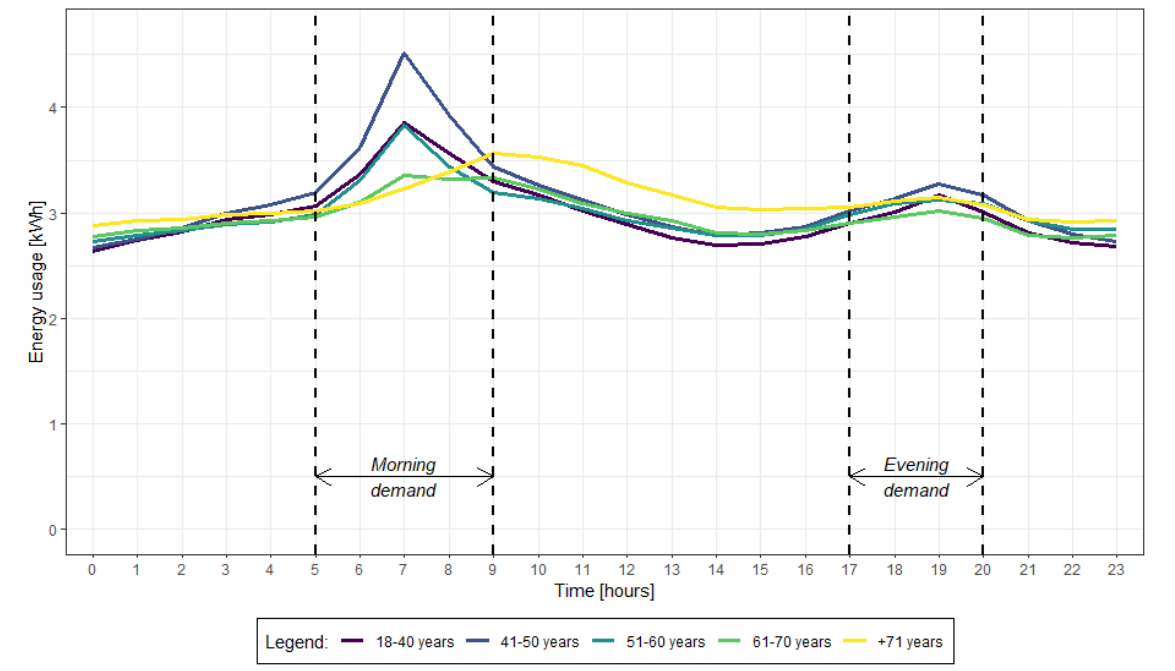
Figure 5. Heat usage profile for an average day for age groups based on the oldest occupant in the household based on average hourly consumption. N = 2,005,091; n = 803.